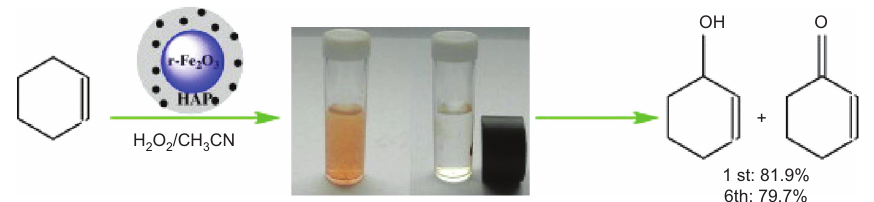
O catalyst from the reaction mixture under an external magnetic field. 2 3